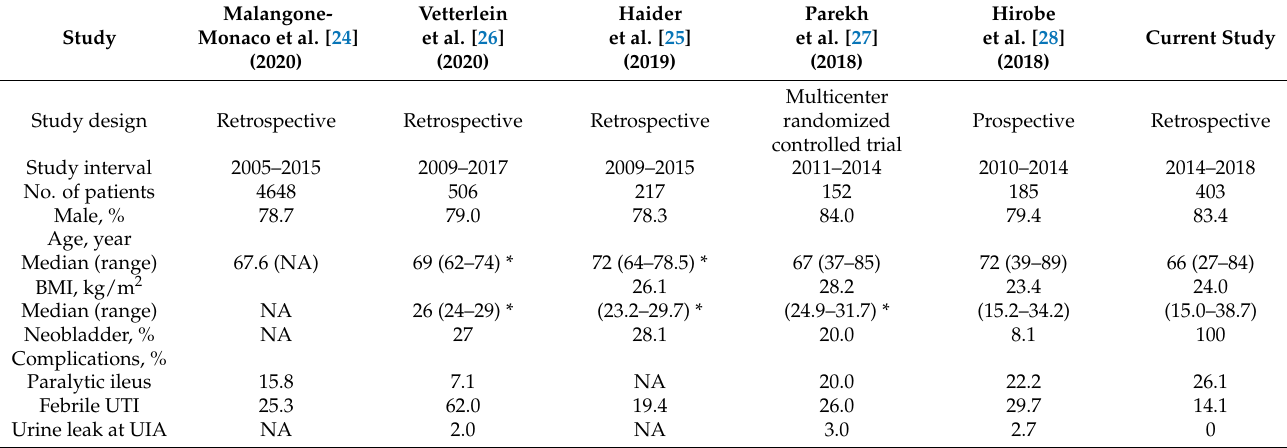
Table 3. Comparison of complications between current study and recent studies with intraoperative ureteral stent indwelling during radical